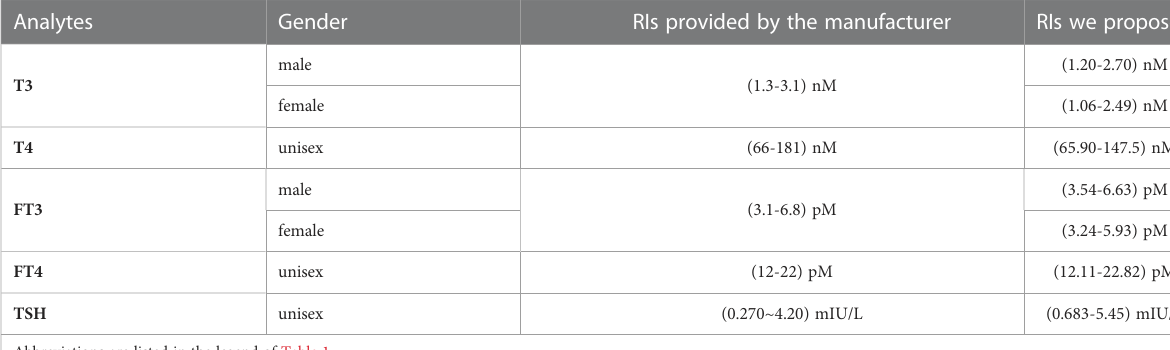
Abbreviations are listed in the legend of Table 1.